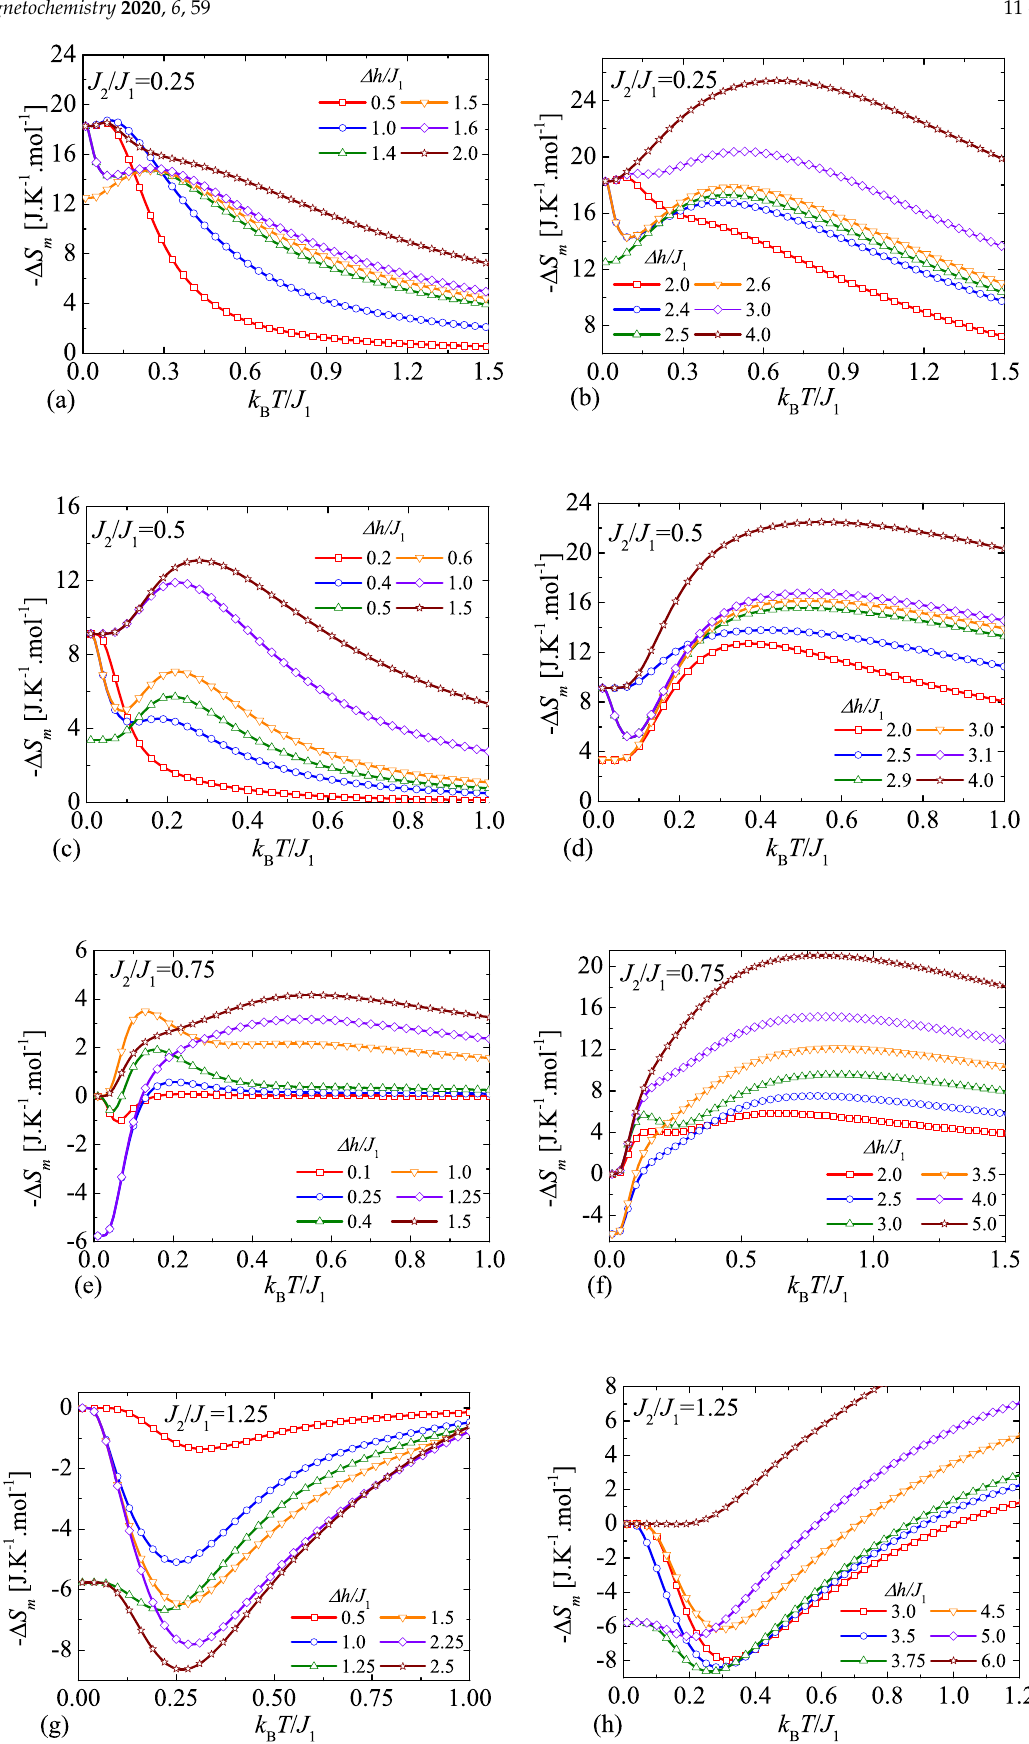
Figure 5. Temperature variations of the isothermal molar entropy change − ∆ S m in J · K − 1 · mol − 1 units for several values of the magnetic-field change ∆ h / J 1 and four different values of the interaction ratio: ( a , b ) J 2 / J 1 = 0.25; ( c , d ) J 2 / J 1 = 0.5; ( e , f ) J 2 / J 1 = 0.75; ( g , h ) J 2 / J 1 =